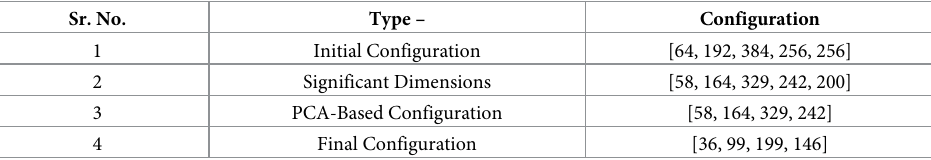
Table 5. Configuration of AlexNet on CIFAR-10.